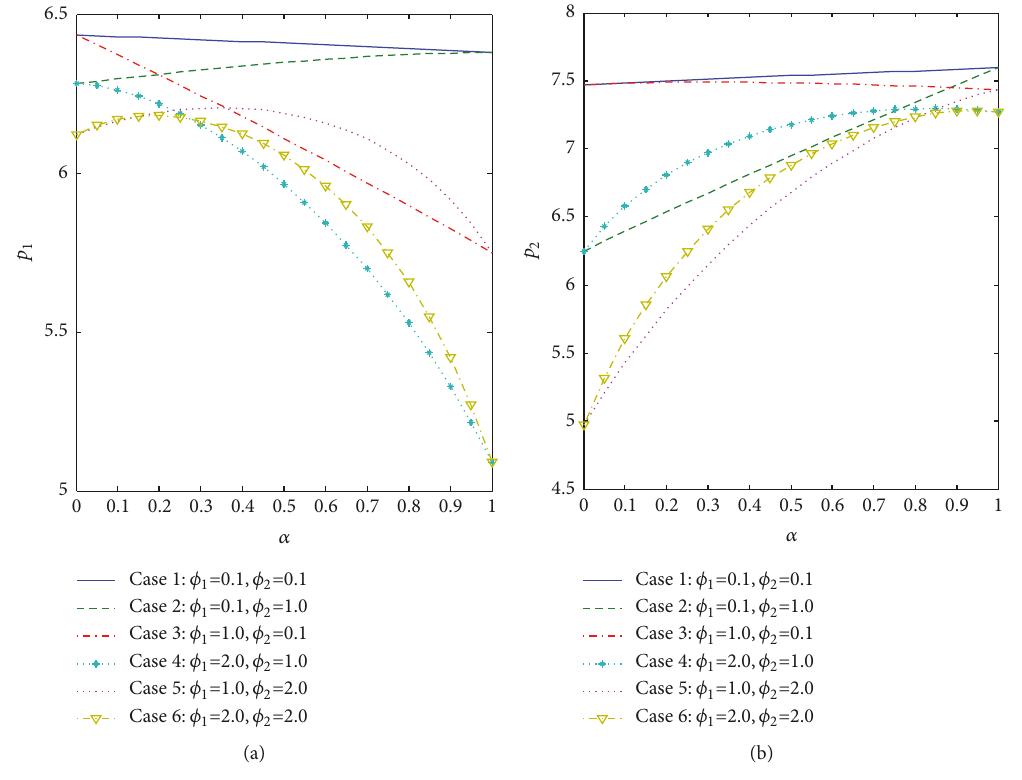
Figure 1: The impact of bargaining power 𝛼 on the price.